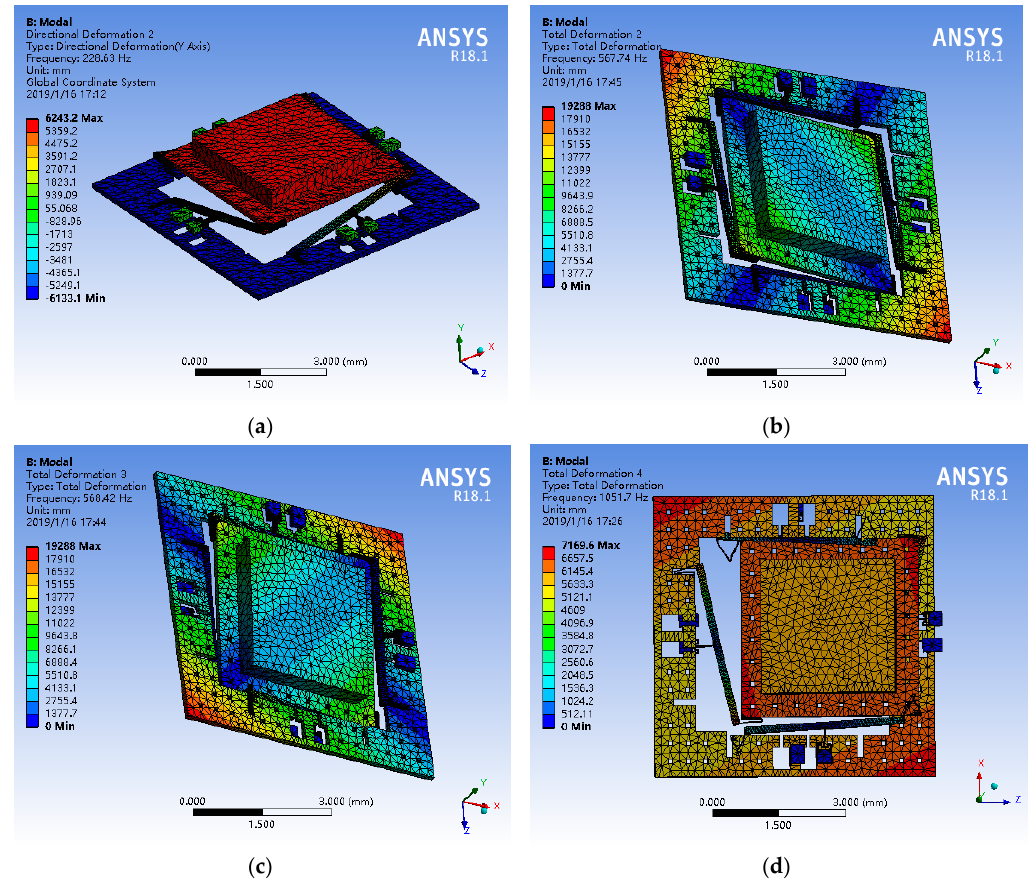
Figure 3. The selected modes of the micromachined z-axis tunneling magnetoresistive accelerometer. ( a ) Linear movement of proof mass along z direction in first mode; ( b ) The off-plane rotation movement of inner proof mass in second mode; ( c ) The off-plane rotation movement of inner proof mass in the third mode; ( d ) The in-plane translational movement of inner proof mass in the fourth mode.